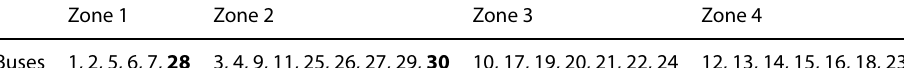
Table 3 Buses in combine